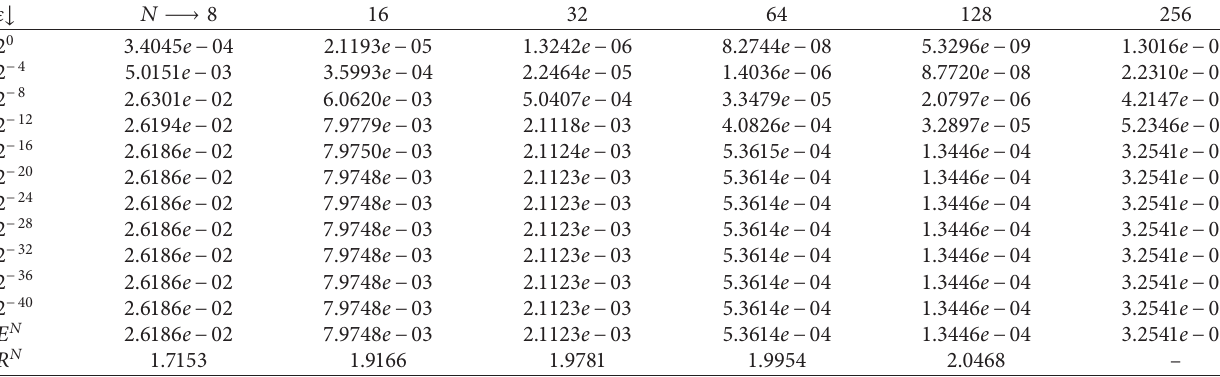
Table 2: Maximum absolute error of Example 1 after Richardson extrapolation for δ � 0 . 6 ε ​ η � 0 . 5 ε .